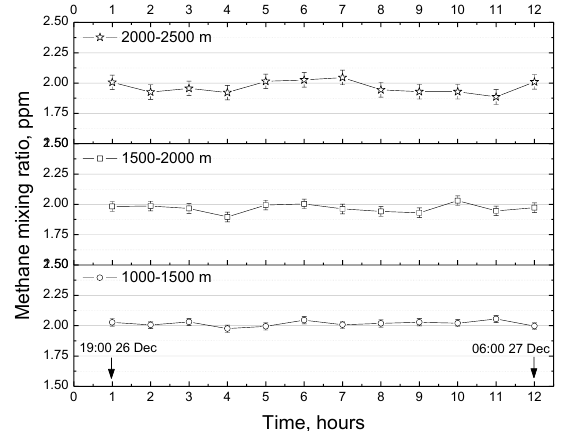
Figure 5. Time series of the methane mixing ratio in the height layers of 1000 – 1500 m, 1500 – 2000 m, 2000 – 2500 m measured on on the night 26-27 December 2018. Averaging time is 1